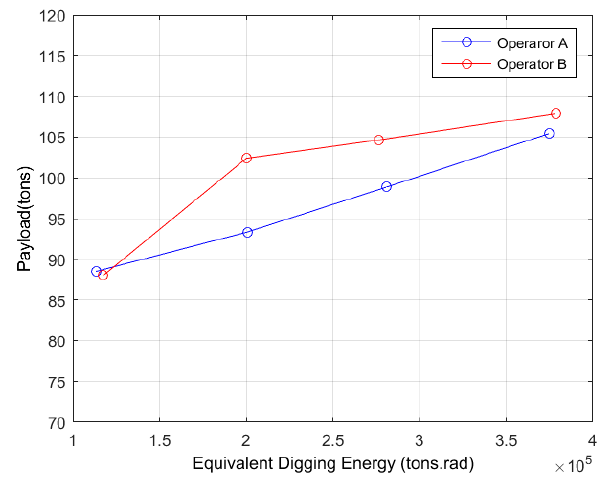
Figure 12. Average payload for different digging energy classes.